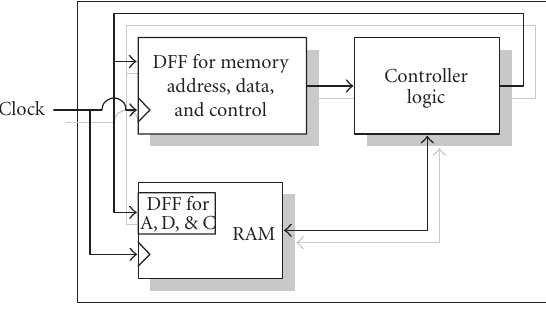
Figure 7: One-phase clock controlling memory latches.